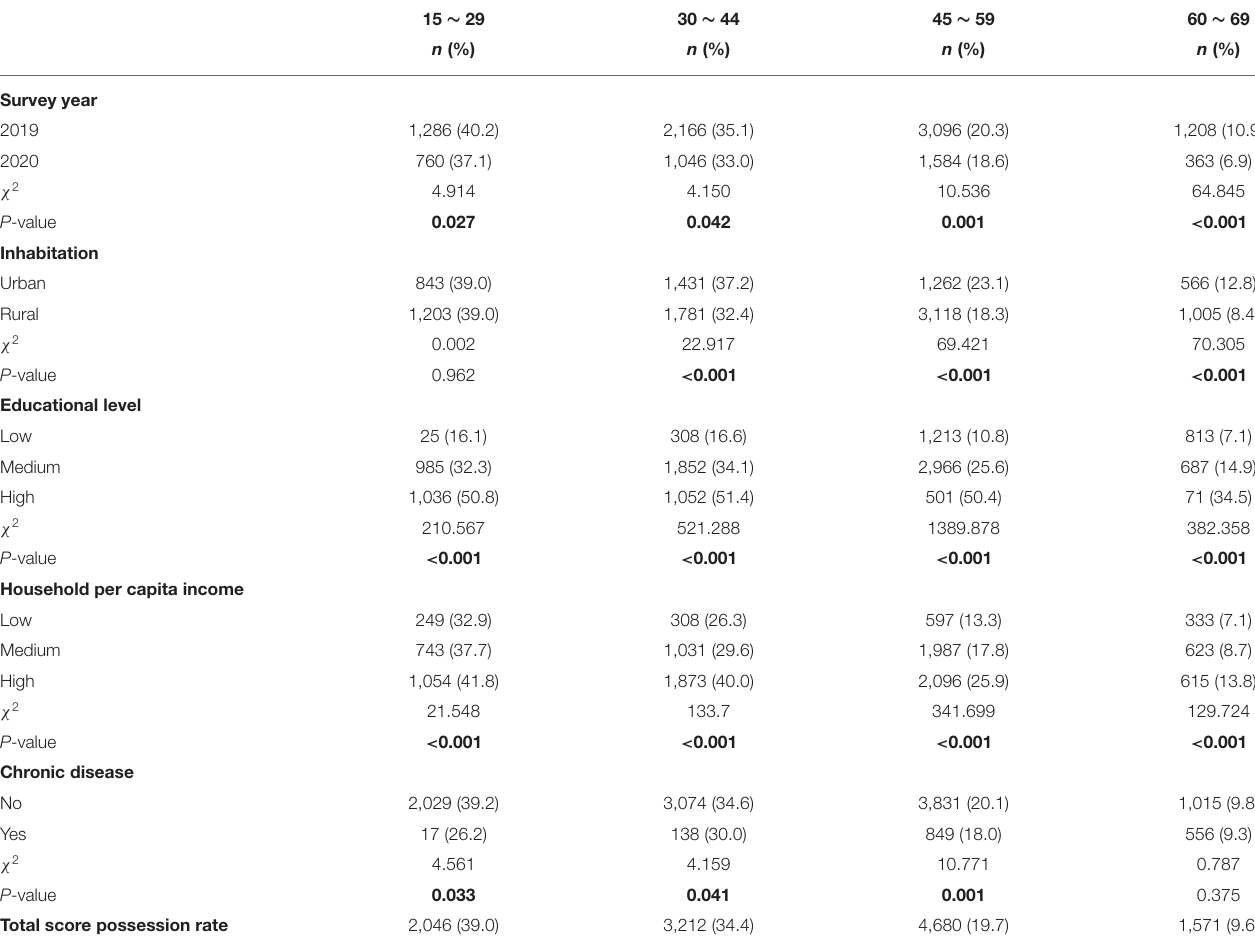
TABLE 1 | Factors associated with health literacy and stratified by age groups—results of Bivariate